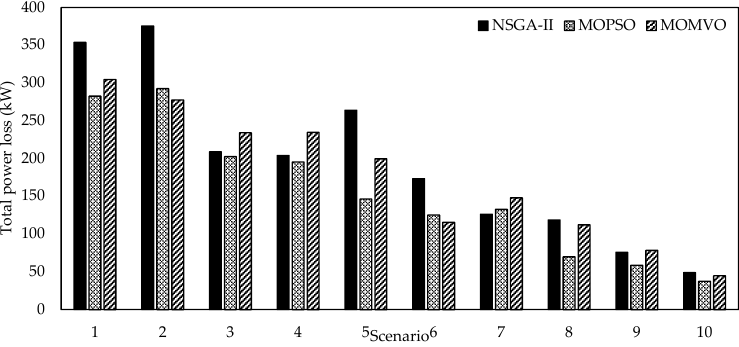
Figure 12. Total power loss for each scenario: 83-node distribution system.